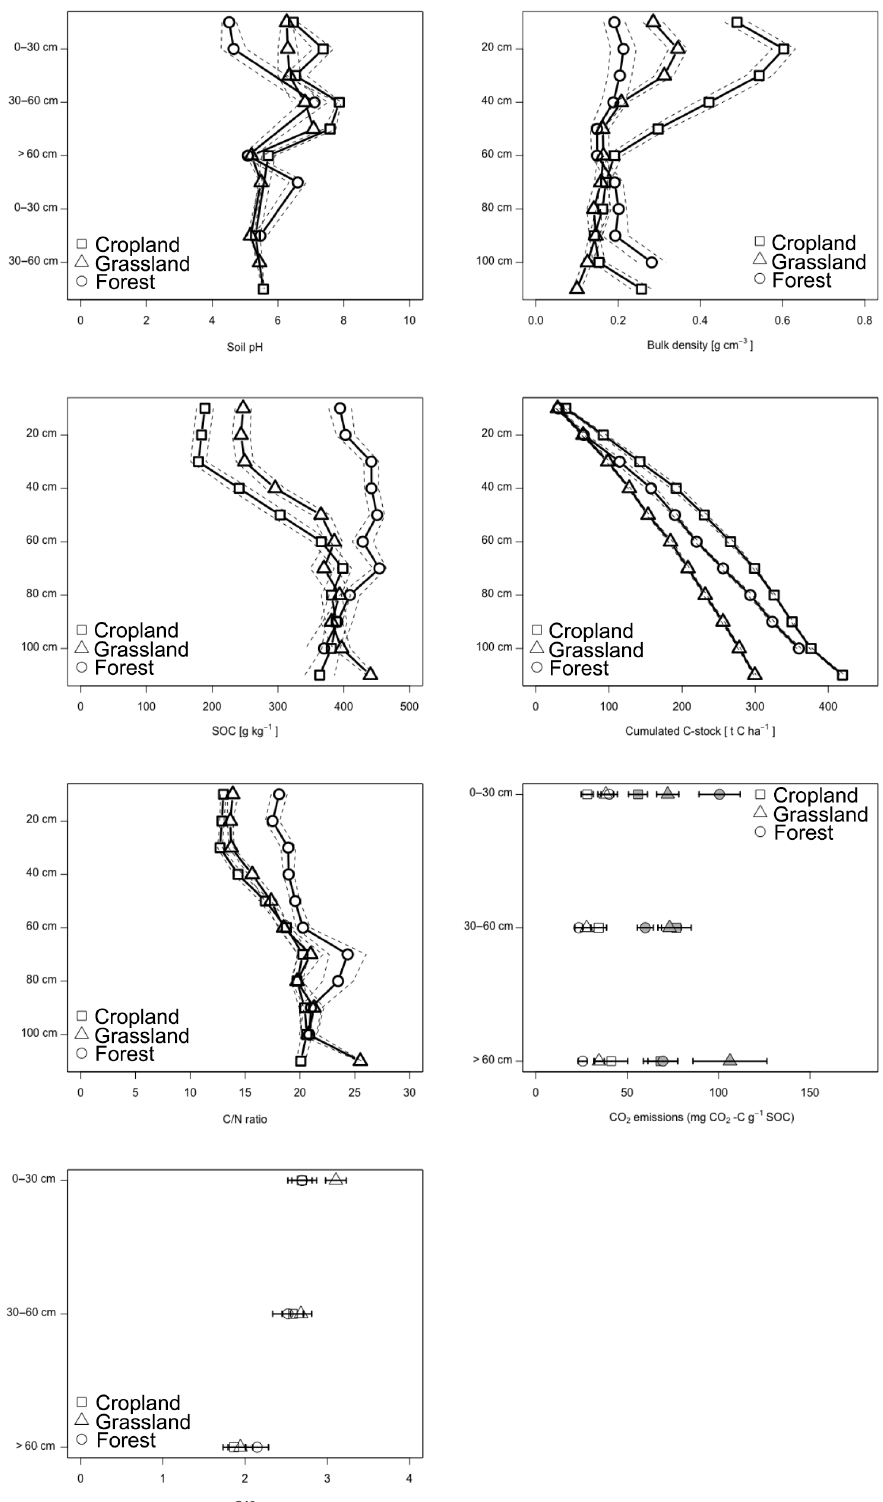
Figure 1. Soil pH, bulk density, SOC content, cumulated C stocks, C / N ratios, CO 2 emissions and temperature sensitivity (Q 10 ) displayed for the three land-use types (cropland, grassland and forest) in relation to the profile depth (cm, y axis). CO 2 emissions are displayed at 10 (open symbols) and 20 ◦ C (black symbols), while the area between dashed lines and error bars represents the standard errors of the